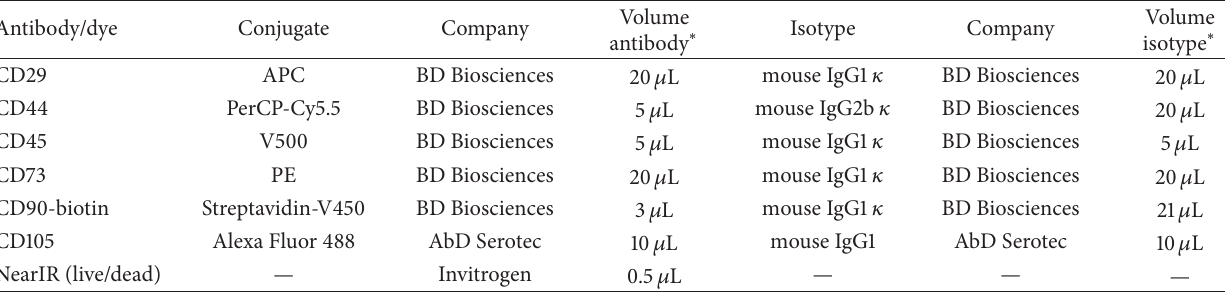
Table 1: Antibodies for analytical fluorescence-activated cell sorting. Volume Antibody/dye Conjugate Company Isotype